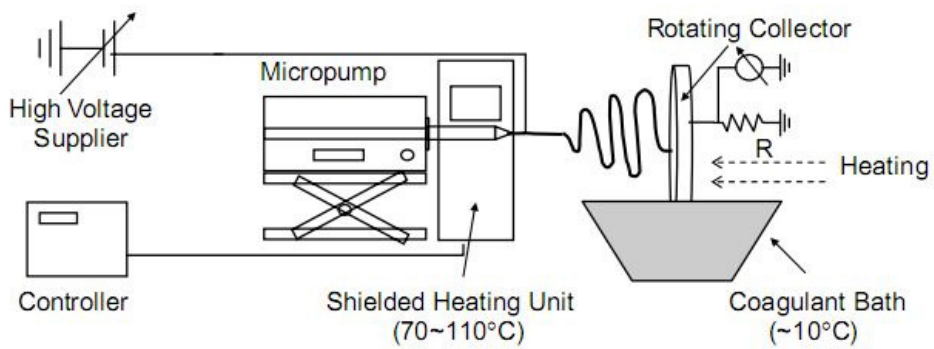
Figure 4. Scheme of the electrospinning system used for production of cellulose fibers (reprinted from Polymer . 2006 , 47 , 5097–5107, Kim, C.W.; Kim, D.S.; Kang, S.Y.; Marquez, M.; Joo, Y.L. Structural studies of electrospun cellulose nanofibers, with permission from Elsevier).